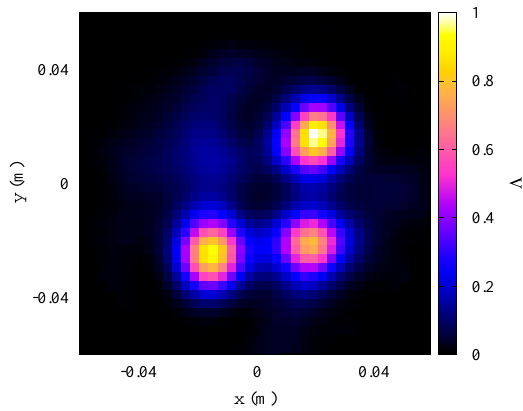
Figure 7. Experimental results. Qualitative indicator map.